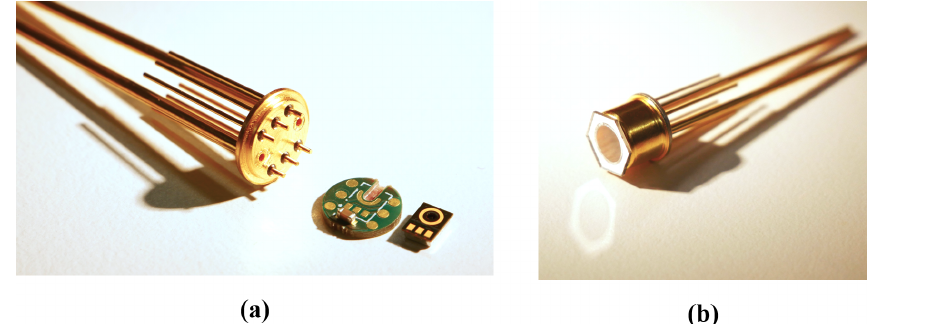
Figure 6. The detection chamber. (a) The base of the housing showing six pins and two tubes that were led through glass feedthroughs in the base. (b) The TO-5 housing cap with a soldered silicon window is soldered to the